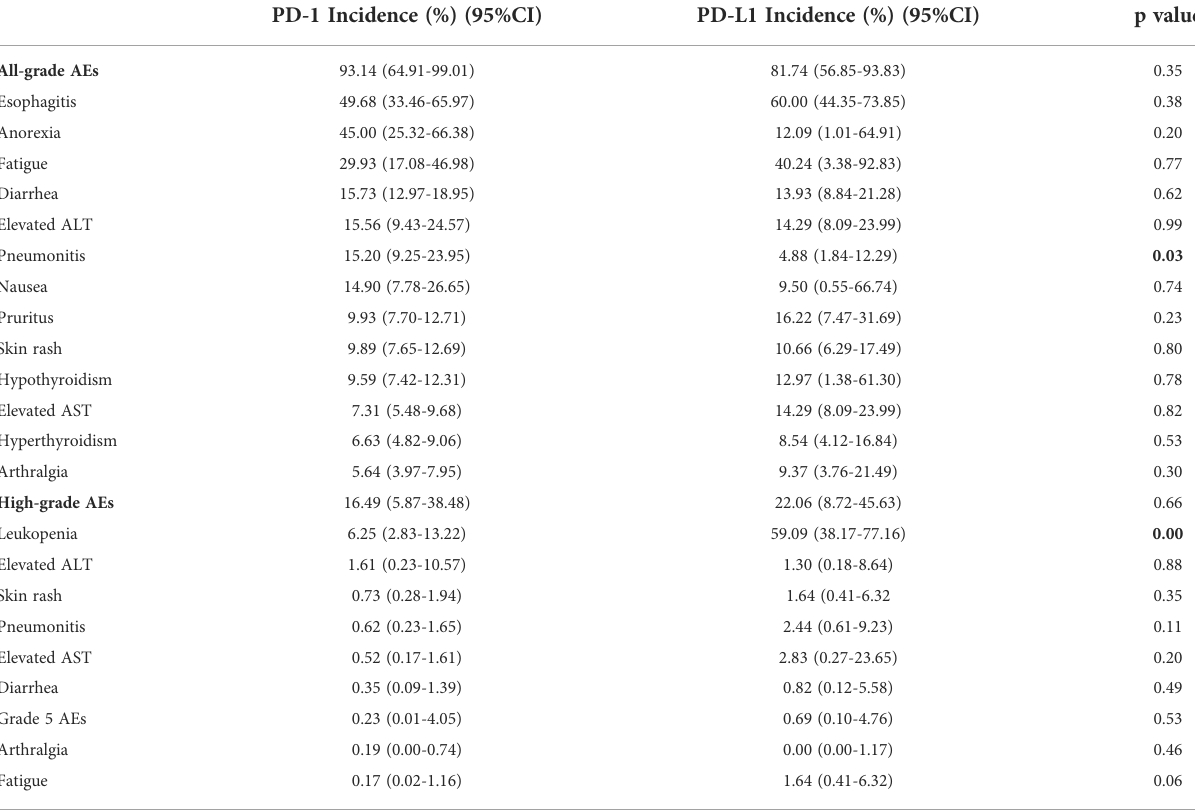
TABLE 3 Differences in the incidence of AEs with PD-1 vs PD-L1 inhibitors combined with